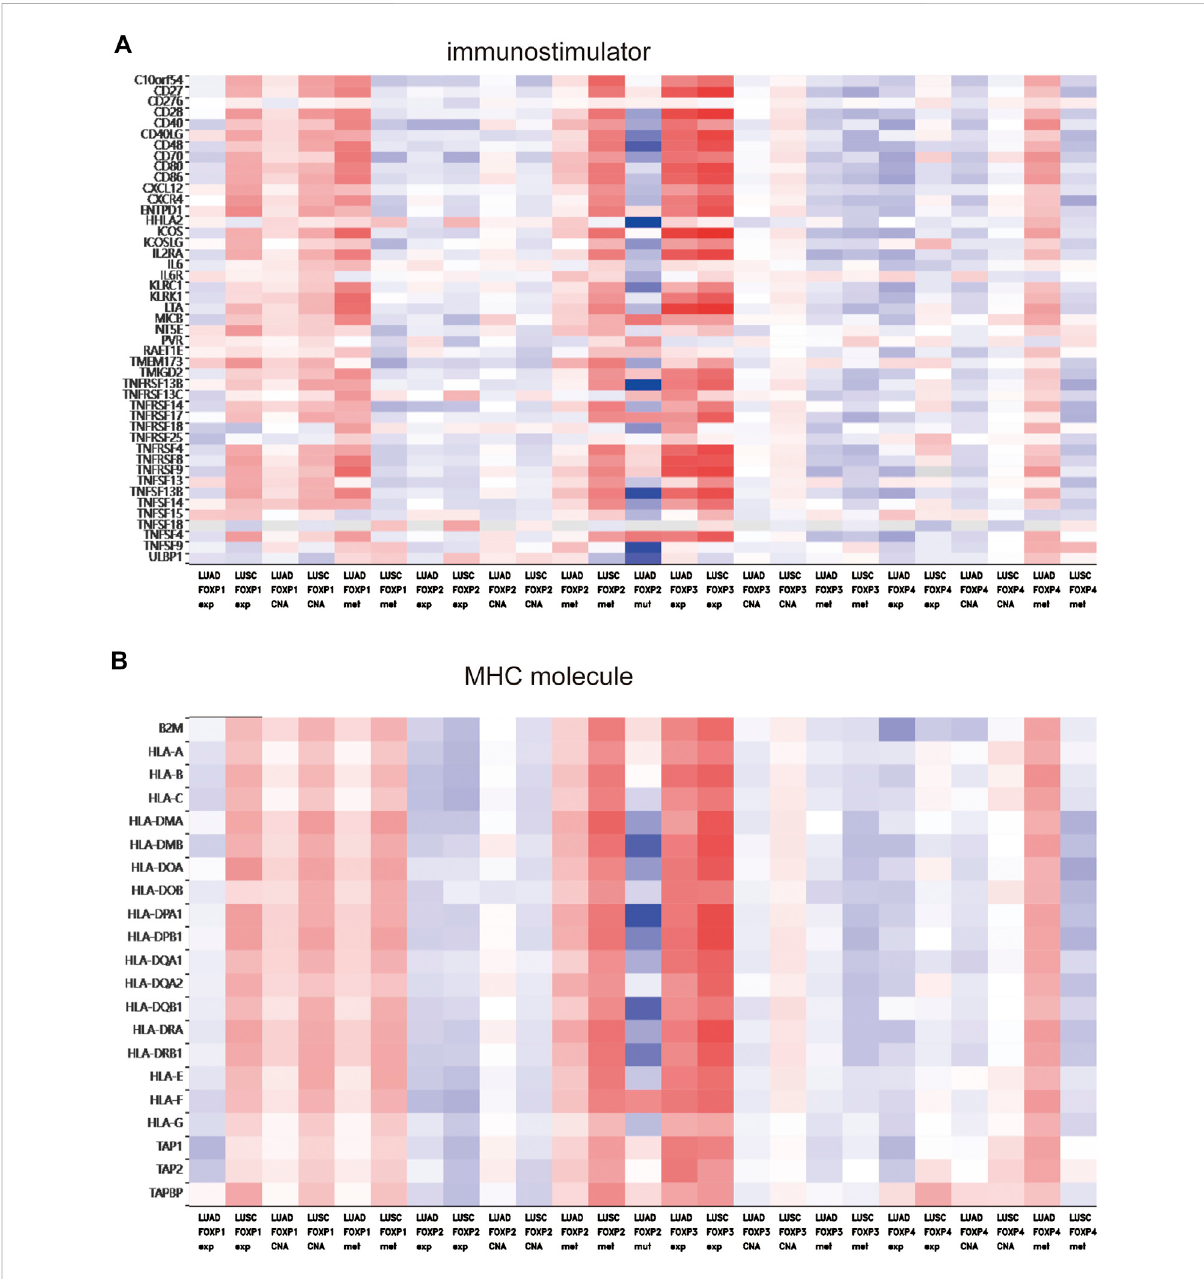
FIGURE 10 Therelationshipbetweenthedegreeofimmunefactorsin fi ltrationinNSCLCandtheexpressionoftheFOXPfamily. (A) Theheatmappresented the correlations between the FOXP family and immunostimulator. (B) The heatmap presented the correlations between the FOXP family and MHC